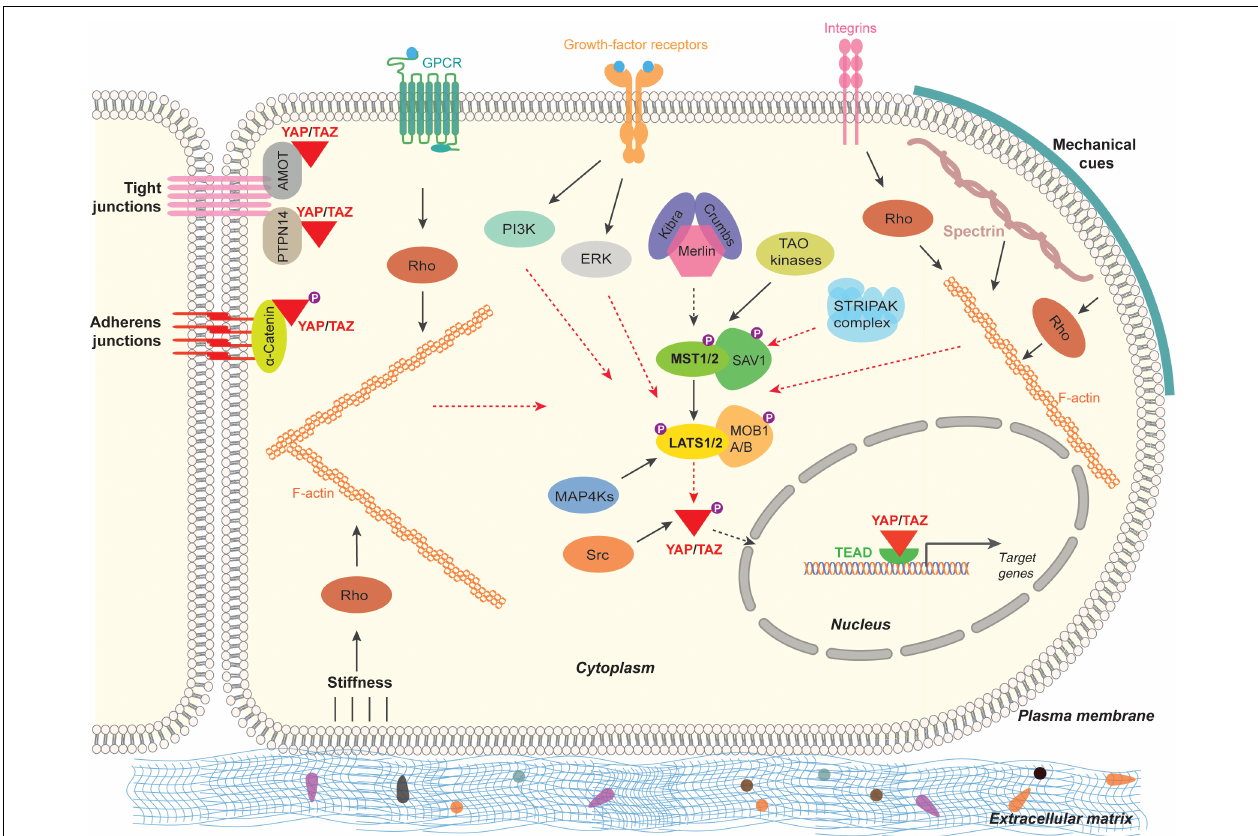
FIGURE 2 | Regulation of the Hippo pathway-YAP/TAZ in mammalian cells. The Hippo signaling pathway-YAP/TAZ in mammals are regulated by multitude of signaling mechanisms. Cell polarity and cell adhesion proteins ( α -Catenin, PTPN14, AMOT), mechanical signals (stiffness caused by ECM, cell contact and cell geometry) and signal transduction (GPCR, growth-factor-receptor, Integrins, Src, MAP4Ks, TAO kinases, STRIPAK complex). Black arrow lines indicates activation and the red arrow dashed lines indicate